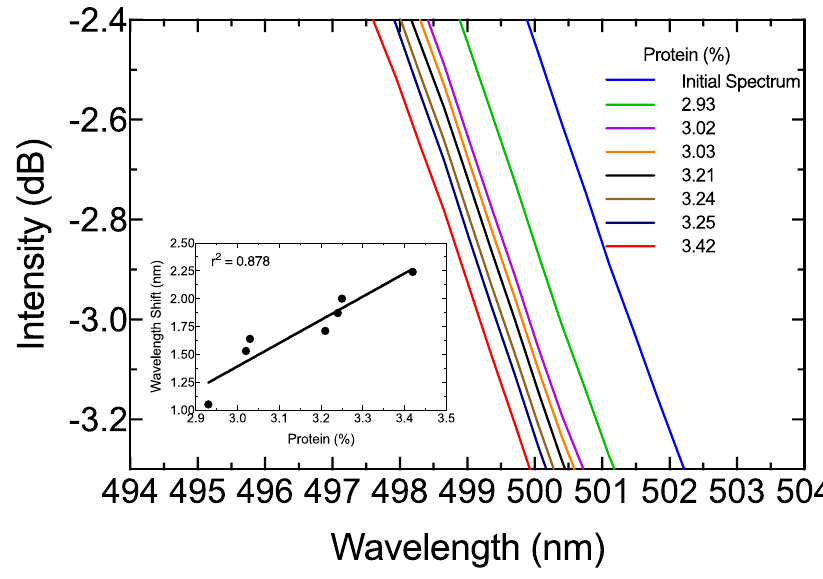
Figure 9. Zoomed-in view of the R2region for protein estimation. Inset is the square adjustment of the wavelength shift from the initial spectrum as reference.